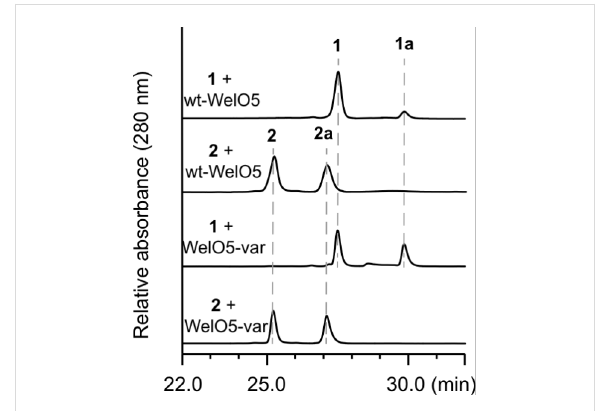
Figure 3: In vitro characterization of a WelO5 variant with enhanced specificity towards 1 . All of the HPLC data shown are in vitro assays conducted with WelO5* or its variants (20 µM) with 0.5 mM of 1 or 2 for 20 min at 30 °C. HPLC was run with a C18 Luna column (Phenomenex 250 × 4.6 mm) with a solvent gradient from 60–90% methanol/water in 30 min at a flow rate 1